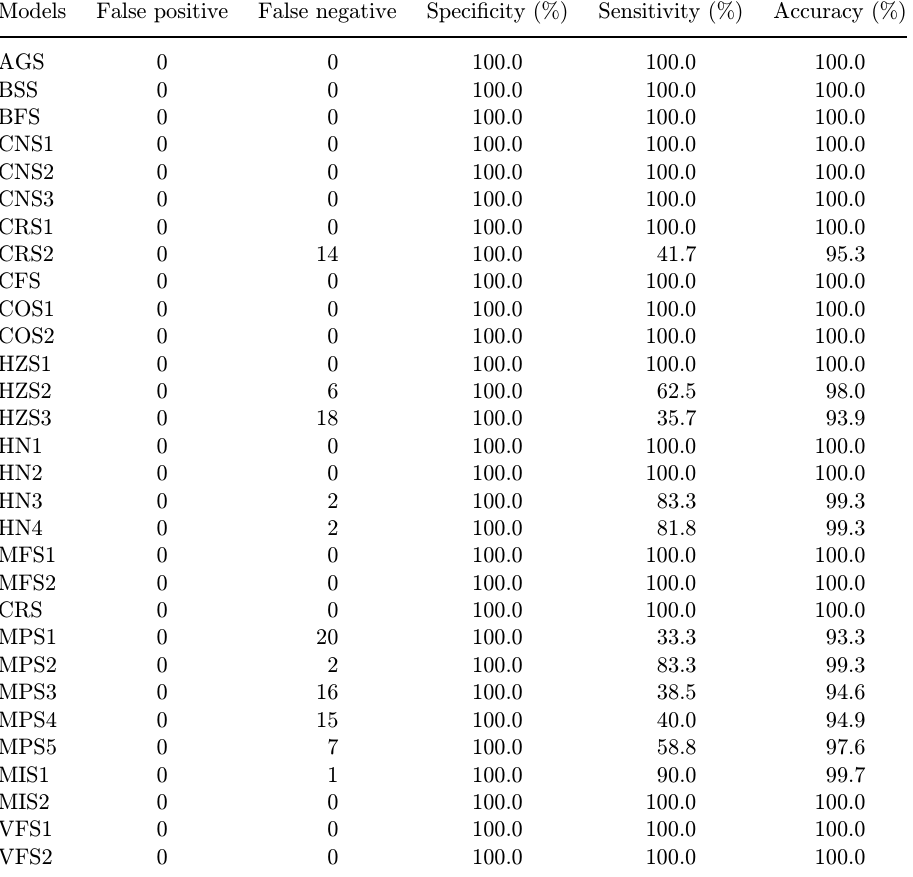
Table 1. Results of identi¯cation types of syrup using